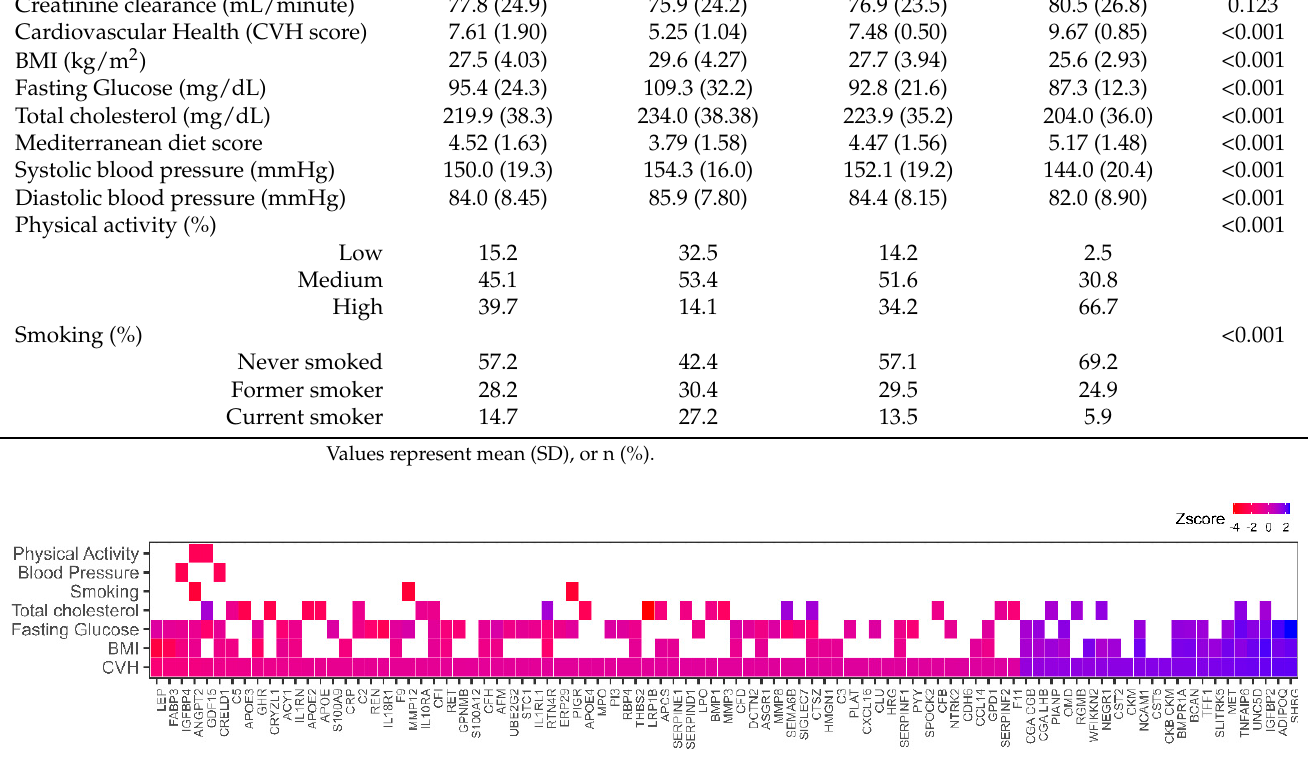
Figure 1. Heatmap displaying the associations between plasma proteins with cardiovascular health (CVH) and individual components of CVH: smoking, physical activity, smoking, blood pressure, total cholesterol, fasting glucose, and body mass index (BMI). None of the CVH associated proteins were associated with dietary intake component.